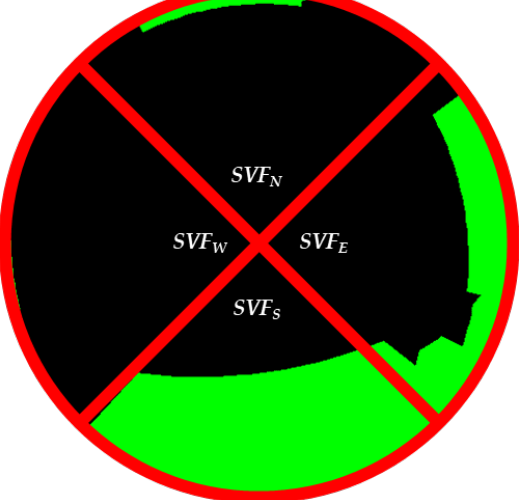
Figure 14. Range of each 𝑆𝑉𝐹 ( 𝑆𝑉𝐹 𝑁 , 𝑆𝑉𝐹 𝑊 , 𝑆𝑉𝐹 𝑆 , 𝑆𝑉𝐹 𝐸 ).